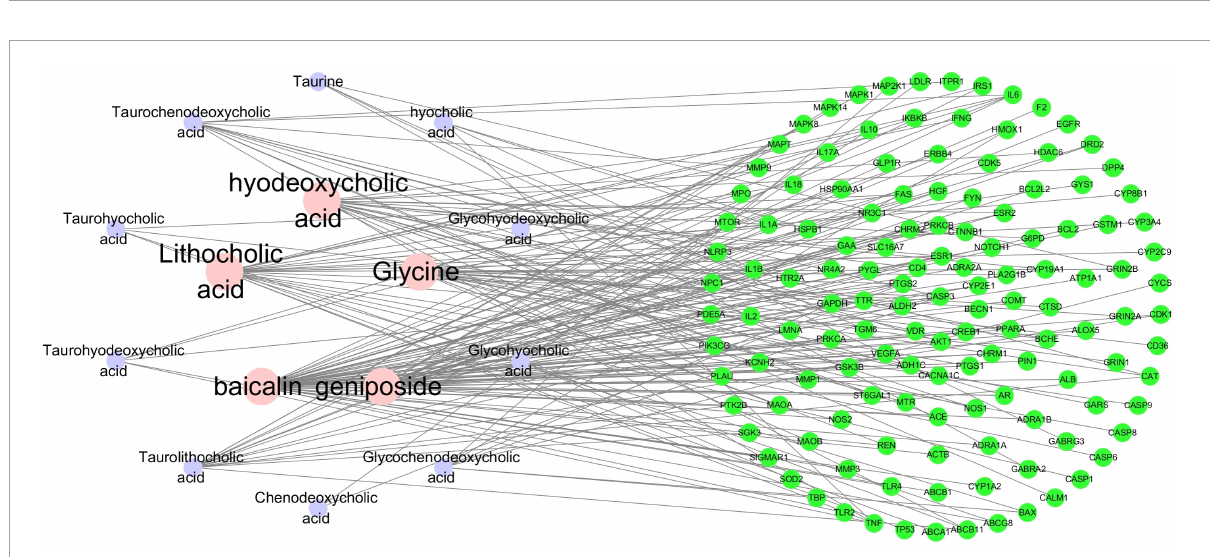
FIGURE3 The Compound-Target Network of the 14 compounds and the 135 common targets. The nodes represent active compounds and target genes, and the edges represent the interaction between them. The degree value of the node represents the number of